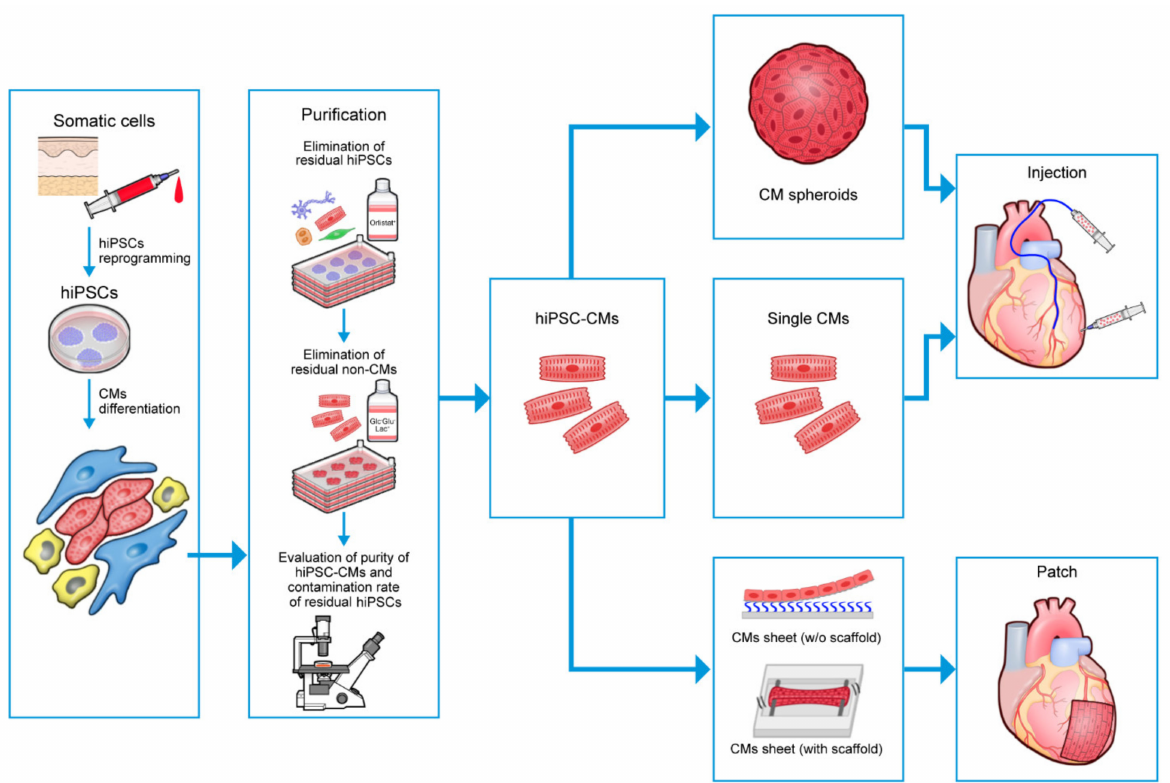
Figure 3. Overview of the scalable manufacturing of clinical-grade hiPSC-CMs. CM, cardiomyocyte; hiPSC, human-induced pluripotent stem cell; hiPSC-CM, human-induced pluripotent stem cell- derived cardiomyocyte; w/o,